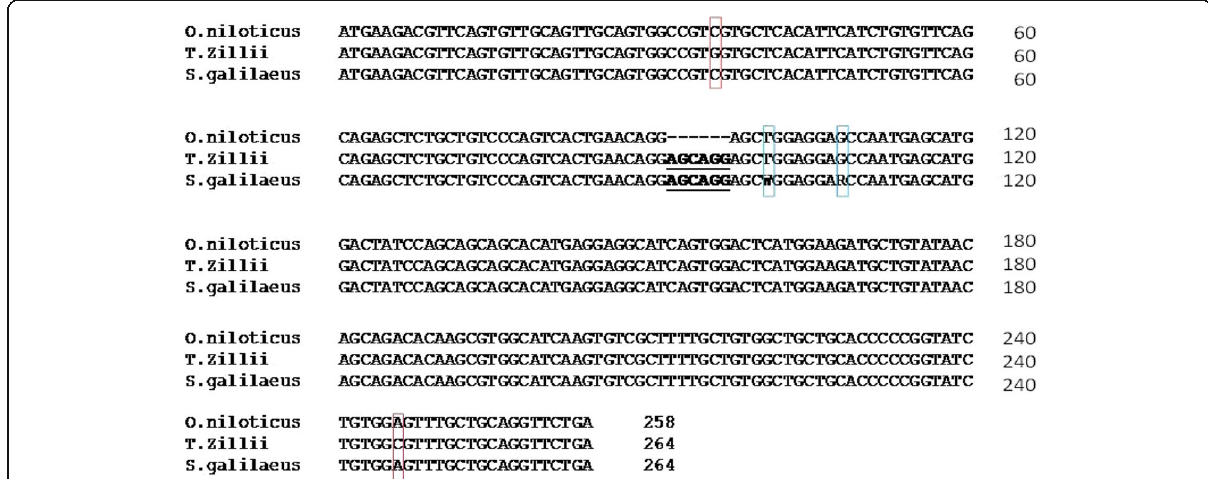
Fig. 2 Alignment of CD regions of O. niloticus , T. zillii , and S. galilaeus species shows two SNPs at nt 36 (C/G) and at nt 240 (A/C) in red box and deletion portion of O. niloticus species in bold and underlined while different genotypes of S. galilaeus species in blue